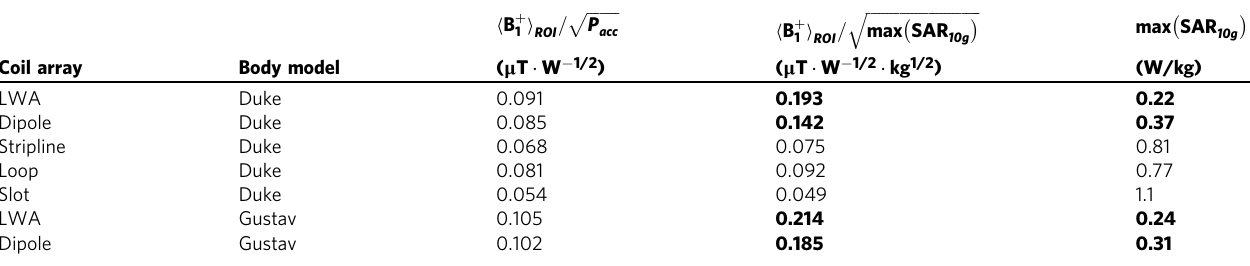
for the four-element LWA array con fi guration ( a ) and a fractionated Fig. 9 In-vivo and safety characterization of four-element LWA array. Simulated B þ 1 dipole array ( b ) in the transverse slice through the prostate of the human body Duke anatomical model for 1 W of accepted power. The corresponding SAR for the LWA array ( c ) and fractionated dipole array ( d ) in a the transverse slice through the maximum of local SAR. In-vivo B þ map in healthy volunteer for 1 LWA array ( e ) and the dipole array ( f ). g In-vivo T 1 -weighted MR image (transverse slice through the prostate) of a healthy volunteer obtained using a four-element array of LWAs and h of dipoles. Table 2 Numerically simulated results of B þ transmit and averaged 10 g-averaged SAR ef fi ciencies for different coils in four- 1 channel con fi gurations placed around two different human body voxel